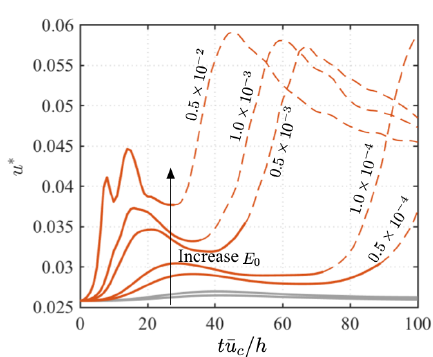
Figure 5. Time evolution of friction velocity u ∗ of case ( α , β ) = ( 1,1 ) initialized by different amplitudes of optimal disturbance E 0 : Red lines represent transition cases, and grey lines denote that the flow remains laminar. Dashed line indicates that the flow is in turbulent state.